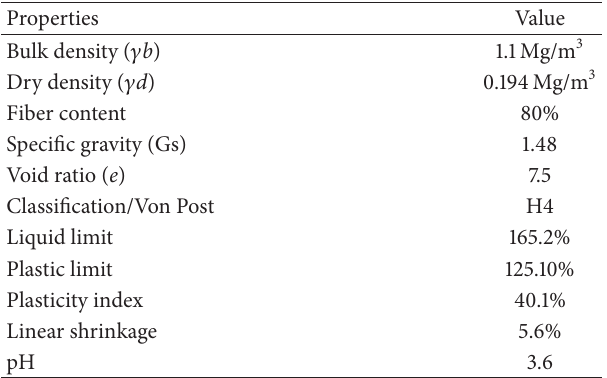
Table 1: Properties of screened peat soil.